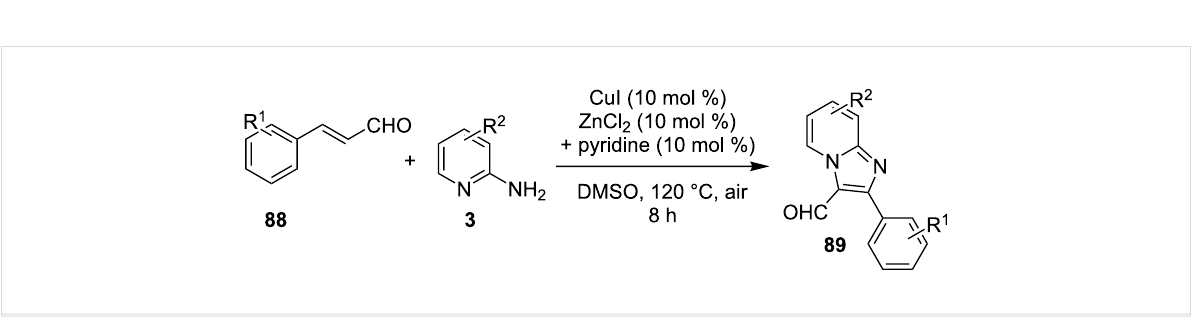
Scheme 28: Mechanism involving Chan–Lam/Ullmann